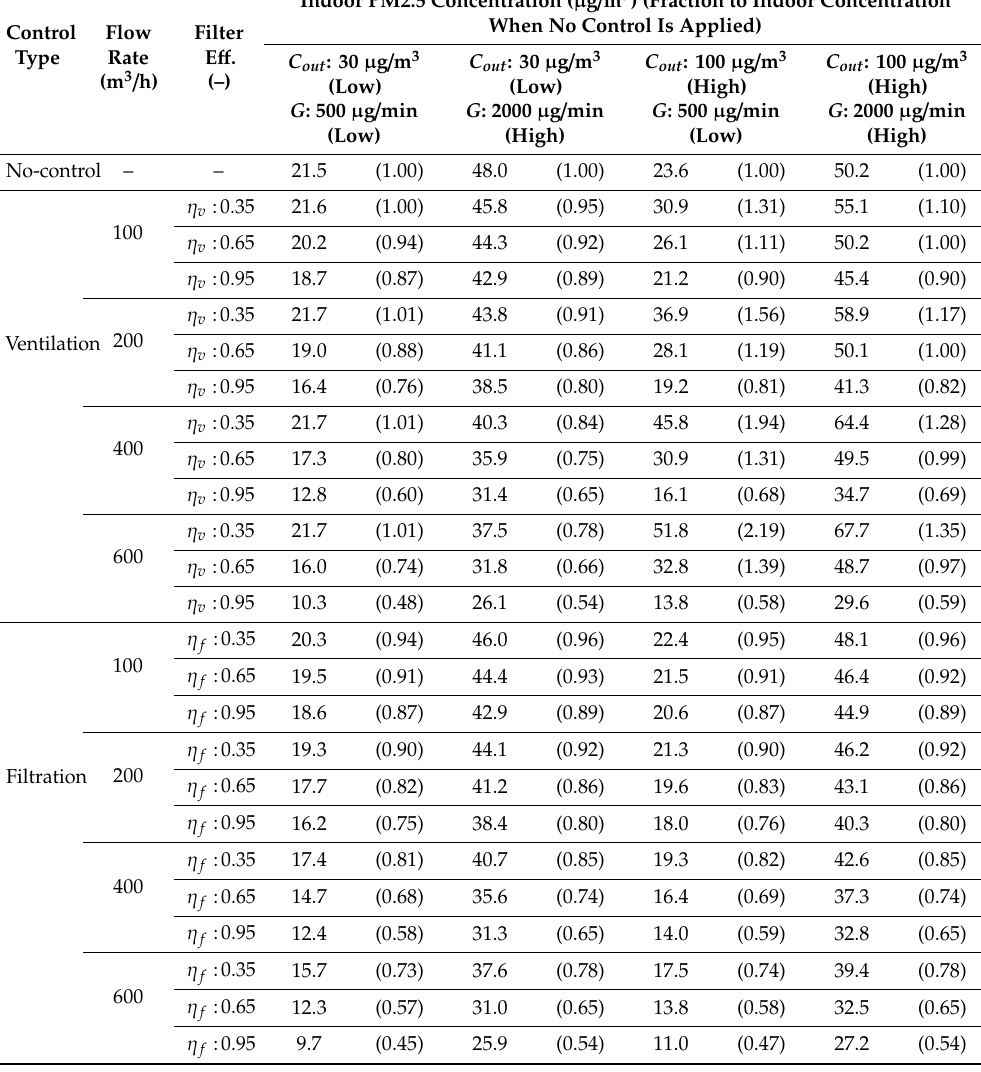
Table 8. Indoor PM2.5 concentration depending on outdoor concentration, indoor generation rate, ventilation flow rates and filter e ffi ciency, and filtration flow rates and filter e ffi